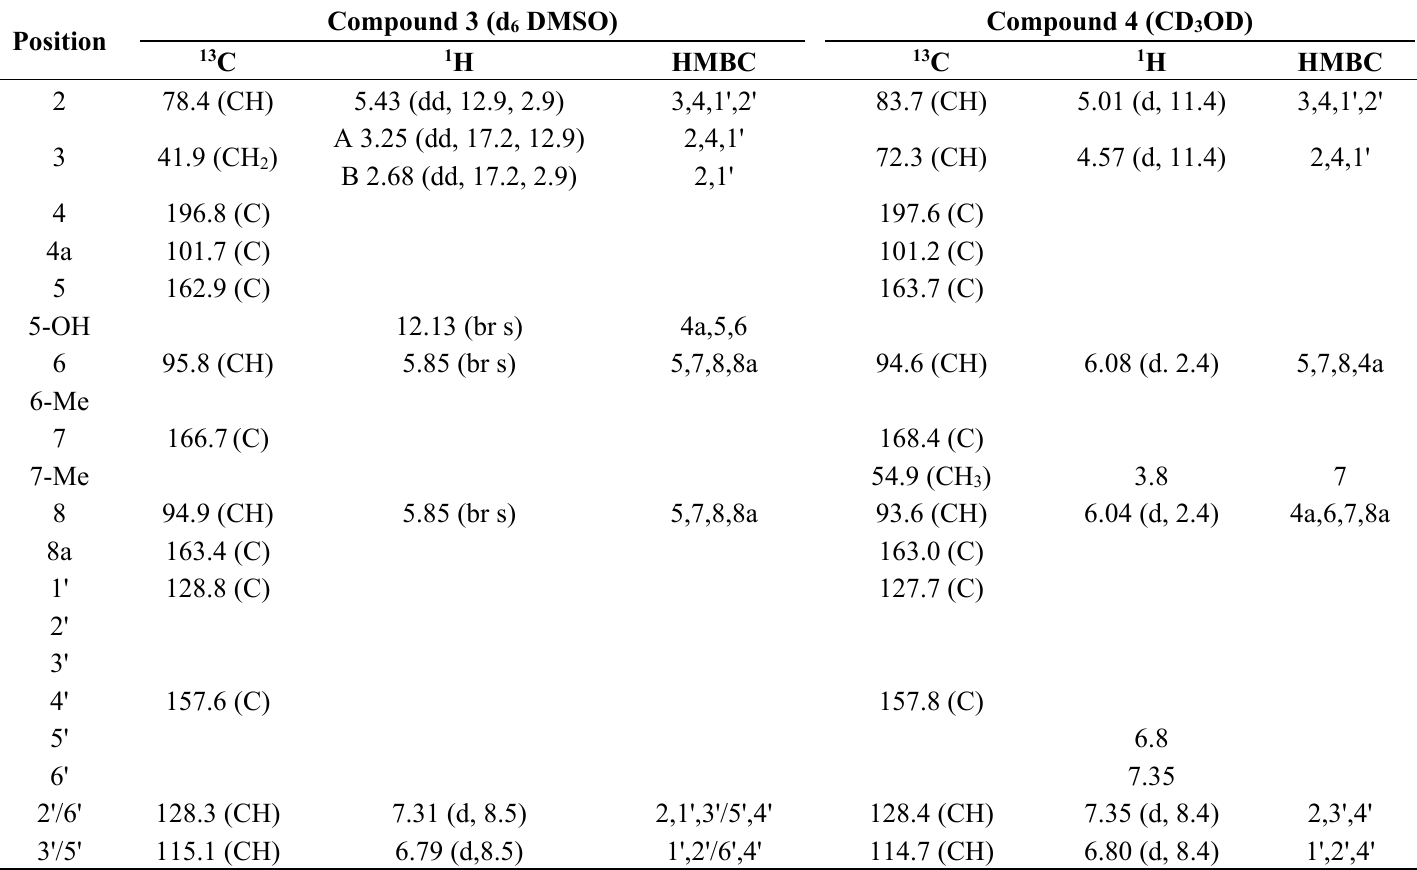
Table 2. 1 H and 13 C-NMR spectral data for compounds 3 and 4 from Corymbia